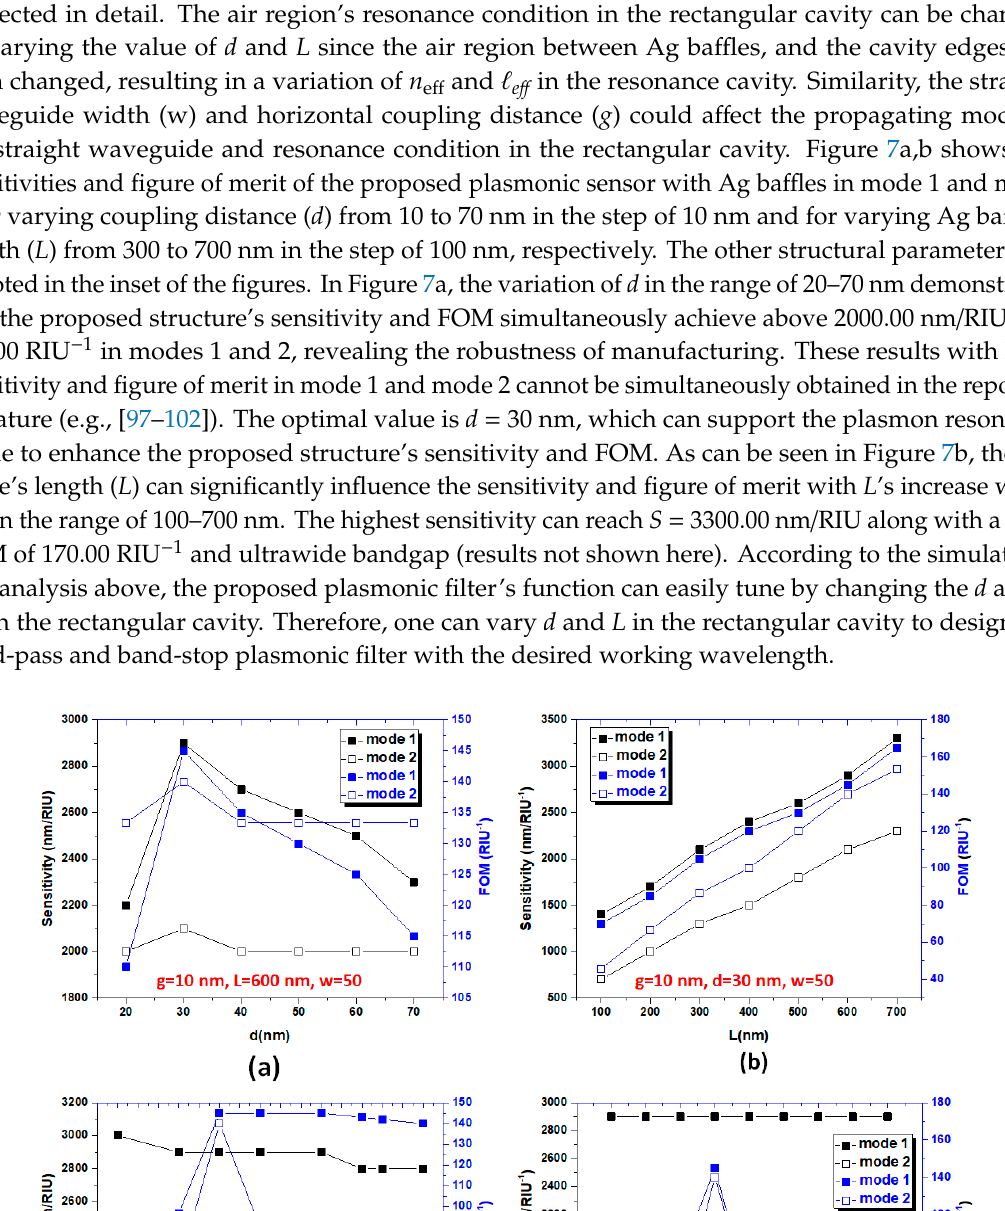
Figure 8. Transmittance spectrum of the proposed plasmonic filter of ( a ) mode 3 and mode 4 and ( b ) mode 1 and mode 2 versus different coupling distances ( g ) and different refractive indices ( n ). The g values are varied from 5, 8, 10, 12 to 15 nm and n values change from 1.00 to 1.01. Finally, we investigate in more detail the influence of coupling distance g on the transmittance, since the structural parameter g of 10 nm would be rather difficult to control experimentally [78]. Figure 8 depicts the transmittance spectrum of the proposed plasmonic filter of mode 3 and mode 4